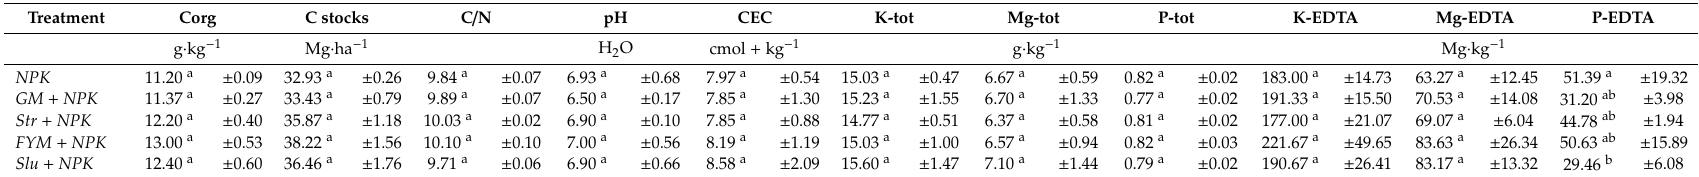
Di ff erent letters indicate significant di ff erences between treatments (mean value ± standard error of mean, p < 0.05; n = 3). Corg: organic carbon; C / N: carbon-to-nitrogen ratio; CEC: cation exchange capacity. NPK : mineral fertilization alone; GM + NPK : green manure + mineral fertilization; Str + NPK : cereal straw + mineral fertilization; FYM + NPK : farmyard manure + mineral fertilization; Slu + NPK : cattle slurry + mineral